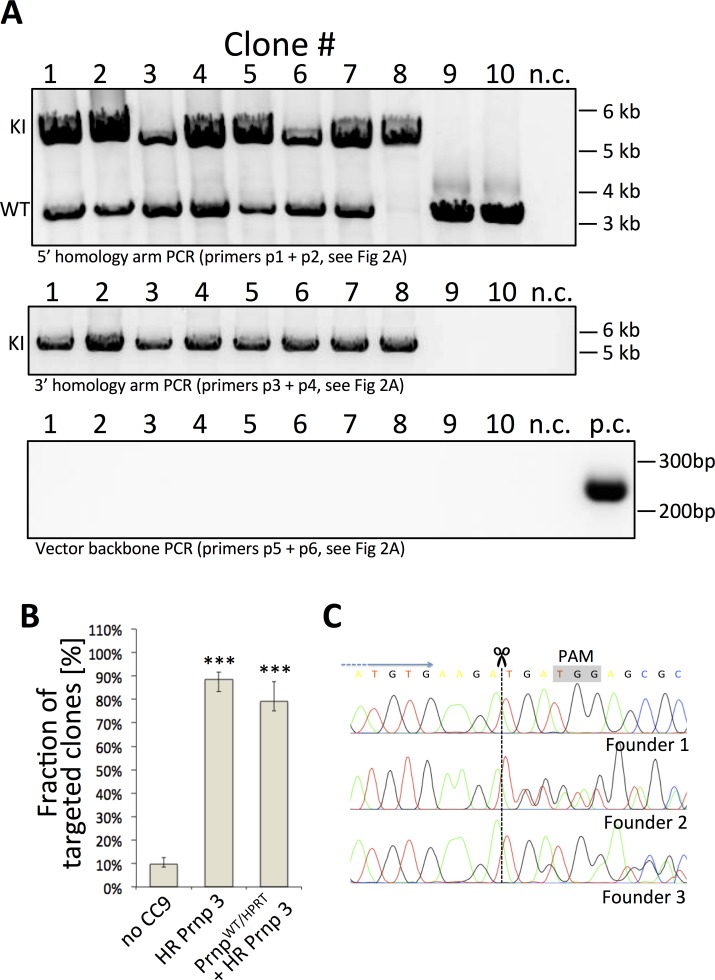
Targeting of the Prnp locus with CRISPR/Cas9.(A) Example PCR showing recombination of a 4kb long transgene into Prnp locus using HR Prnp 3 sgRNA; n.c.–negative control; p.c.–positive control; M—marker ladder. Reverse primer in the top panel anneals to both, WT and MUT sequences, and thereby can discriminate between homozygous and heterozygous knock-in; Clone #8 was confirmed to be homozygous. (B) Cumulative CC9 targeting efficiency assessment of with HR Prnp 3 sgRNA in unmodified V6.5 and V6.5 Prnp(WT/HPRT) cells (containing only one copy of WT Prnp gene). “***”—p < 0.001; Cochran-Mantel-Haenszel test. (C) Fragments of sequencing chromatograms of DNA isolated from founder mice obtained by pronuclear injection of CC9 with HR Prnp 3 sgRNA. DNA sequencing of two out of three founders revealed a shift in electrophoregram corresponding to an in-del in the nuclease target site in one of the alleles. The relevant PAM sequence was shaded in gray.